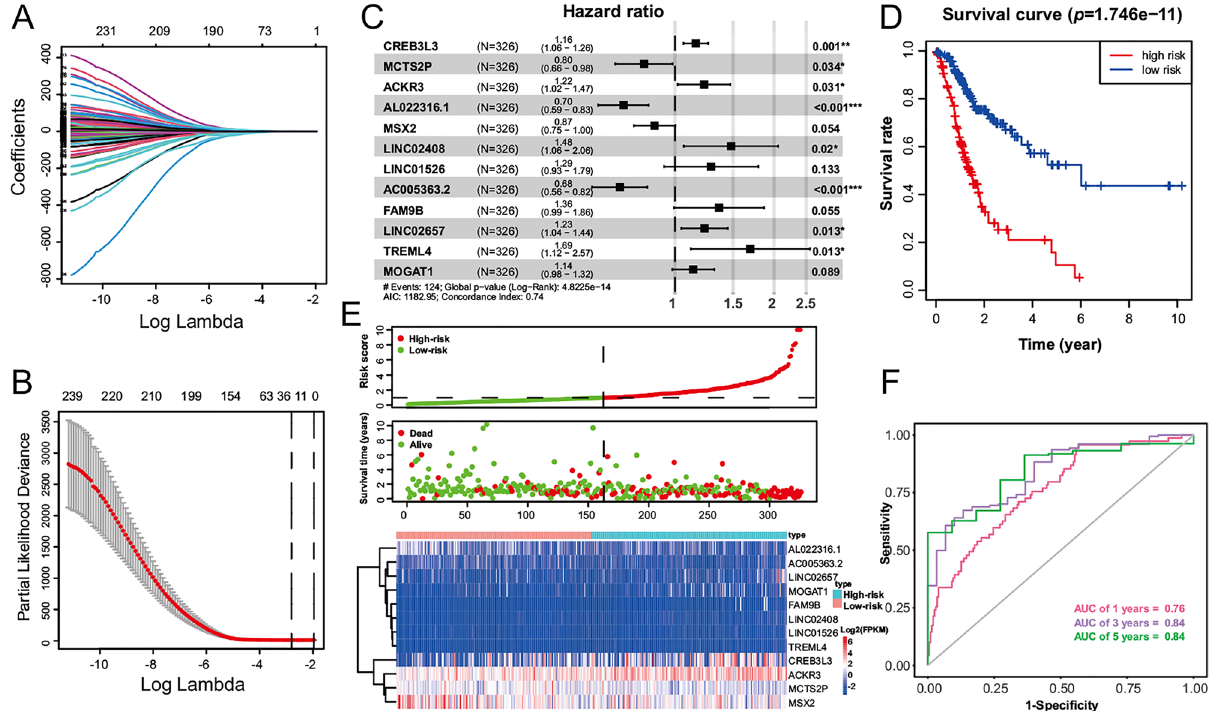
Figure 3. Constructing a prognostic prediction model for STAD. ( A ) The coefficients of lasso regression over different penalty parameter. ( B ) The optimal parameter lambda in lasso regression model. ( C ) Forest plot of the 12 prognostics related DEeRRGs. ( D ) KM curves compare the difference of OS between the high-risk group and low-risk group. ( E ) The distinct distributions of risk score (top panel), survival status (middle panel) and expression heatmap of 12 prognostics (bottom panel) between high-risk group and low-risk group. The color represents the value of log2FPKM. ( F ) The ROC curve of the risk score for predicting 1-, 3-, 5-year